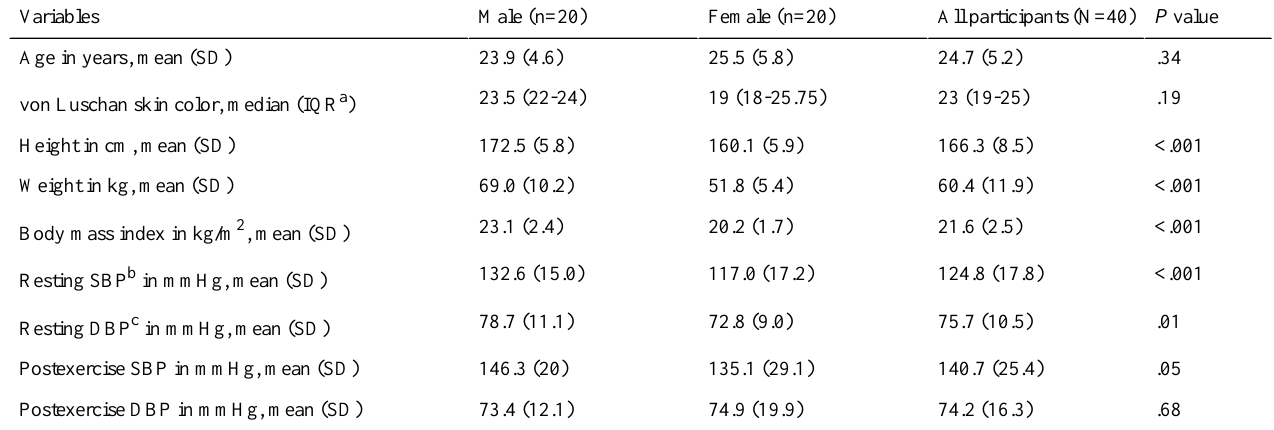
Table 1. Baseline characteristics of the study participants.